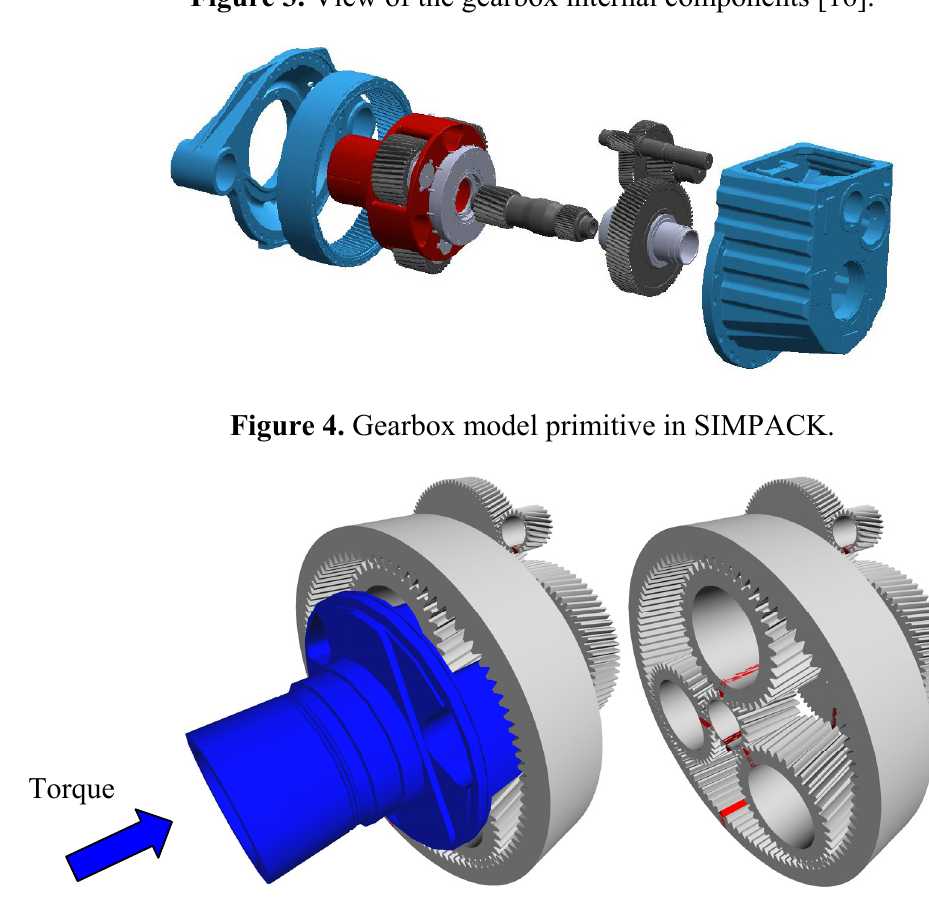
Figure 5. Time histories of main shaft torques when using the 4P